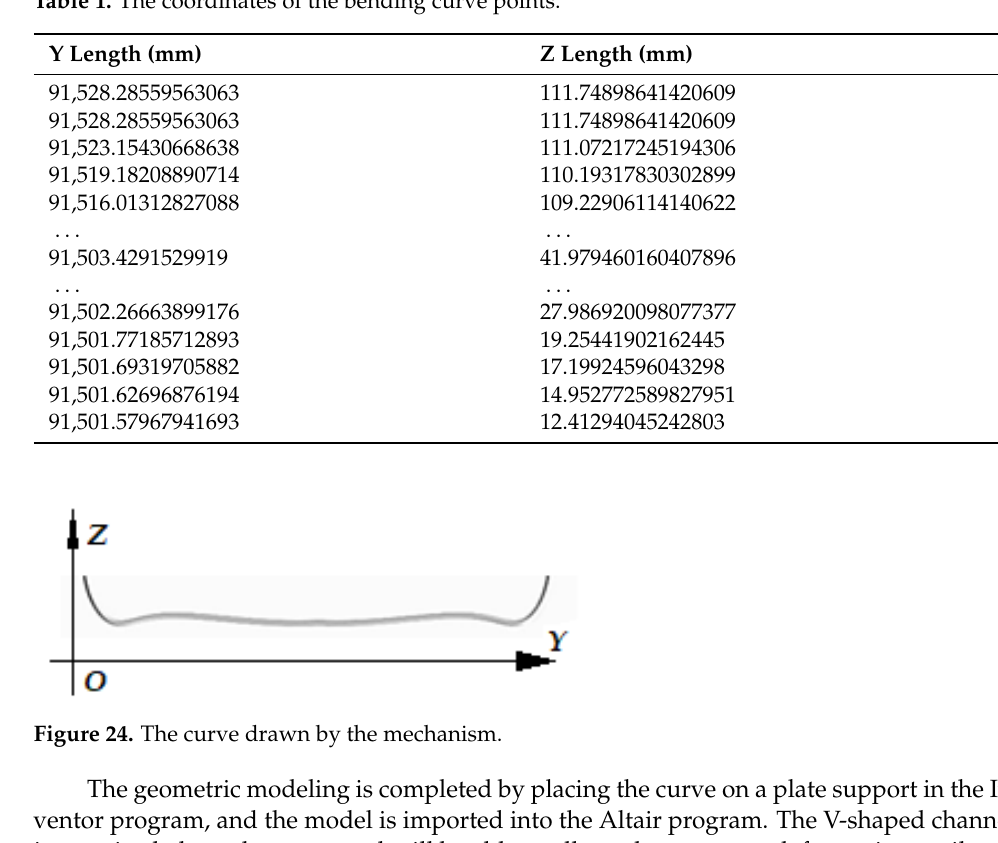
Table 1. The coordinates of the bending curve points.